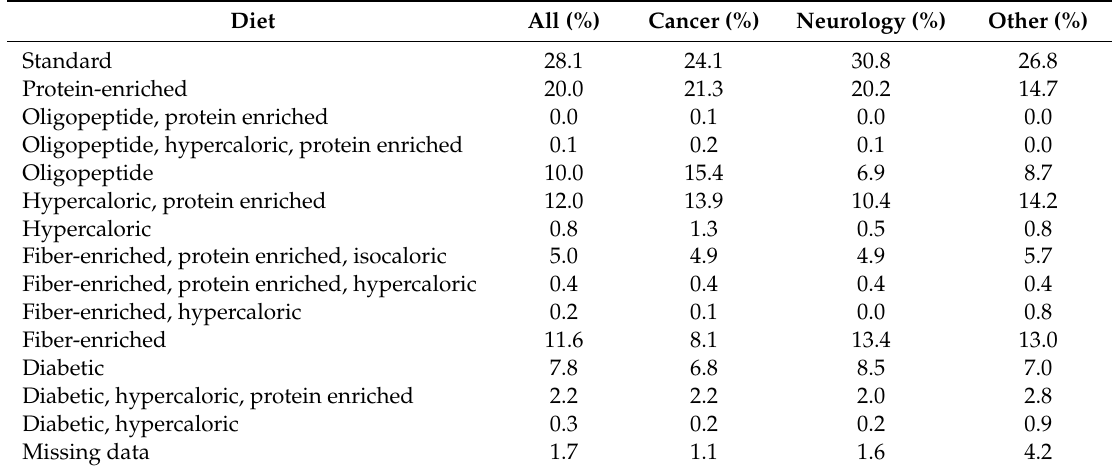
Table 4. Types of enteral